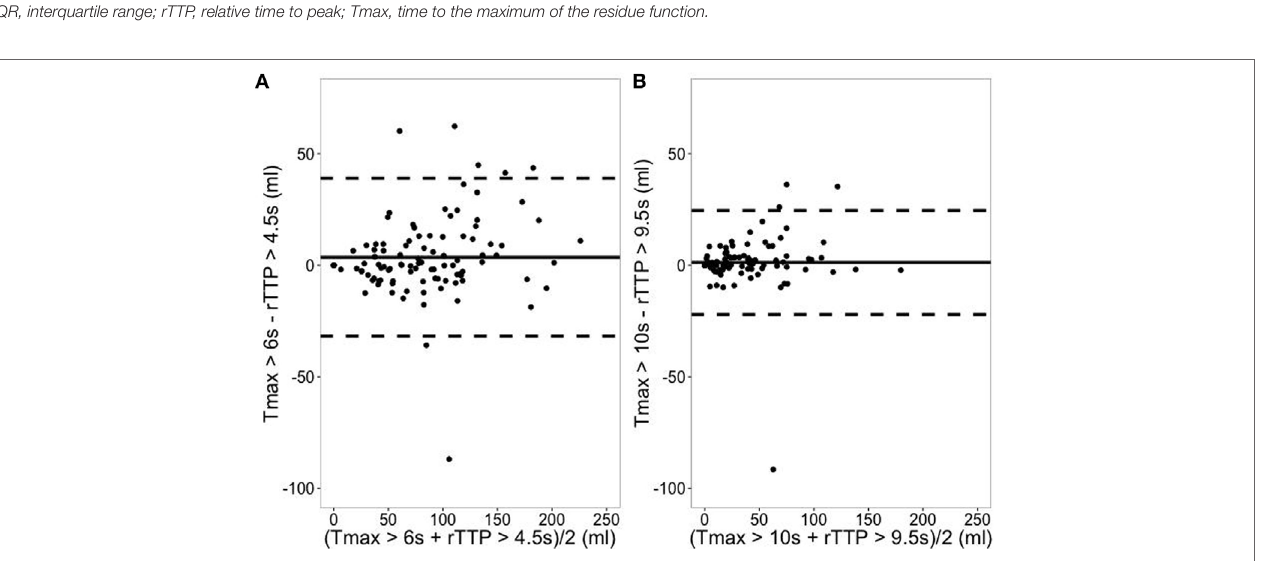
FigUre 2 | Correspondence between relative TTP (rTTP) and Tmax lesion volumes. (a) Represents the Bland–Altman plot for critical hypoperfusion. Solid line depicts the mean difference between Tmax > 6 s and rTTP > 4.5 s (mL) with its 95% prediction interval in dashed lines. (B) Represents the Bland–Altman plot for severe hypoperfusion. Solid line depicts the mean difference between Tmax > 10 s and rTTP > 9.5 s (mL) with its 95% prediction interval in dashed lines.